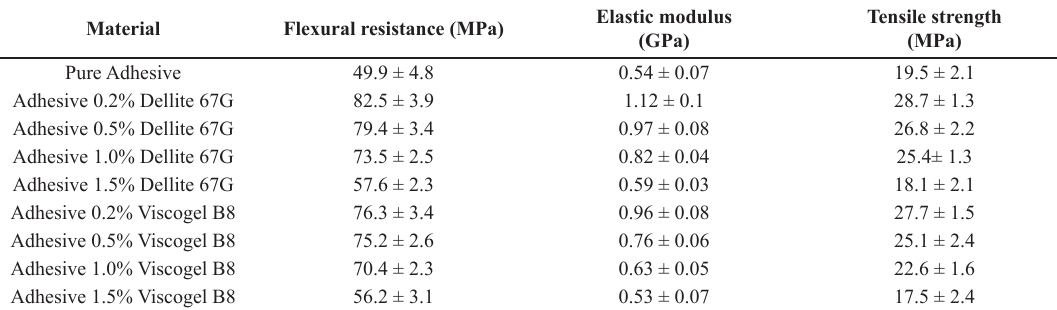
Table 4. Mean and standard deviation of flexural resistance, elastic modulus and tensile strength of dental adhesives